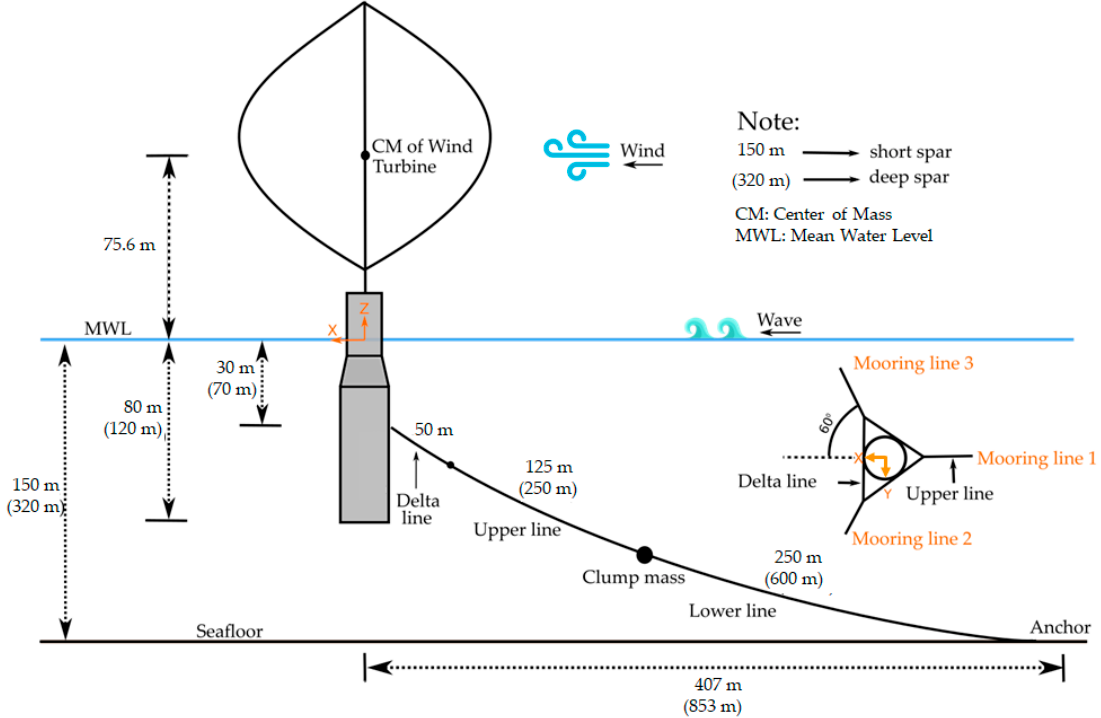
Figure 2. The diagram of the mooring system for the short spar and deep spar VAWTs.